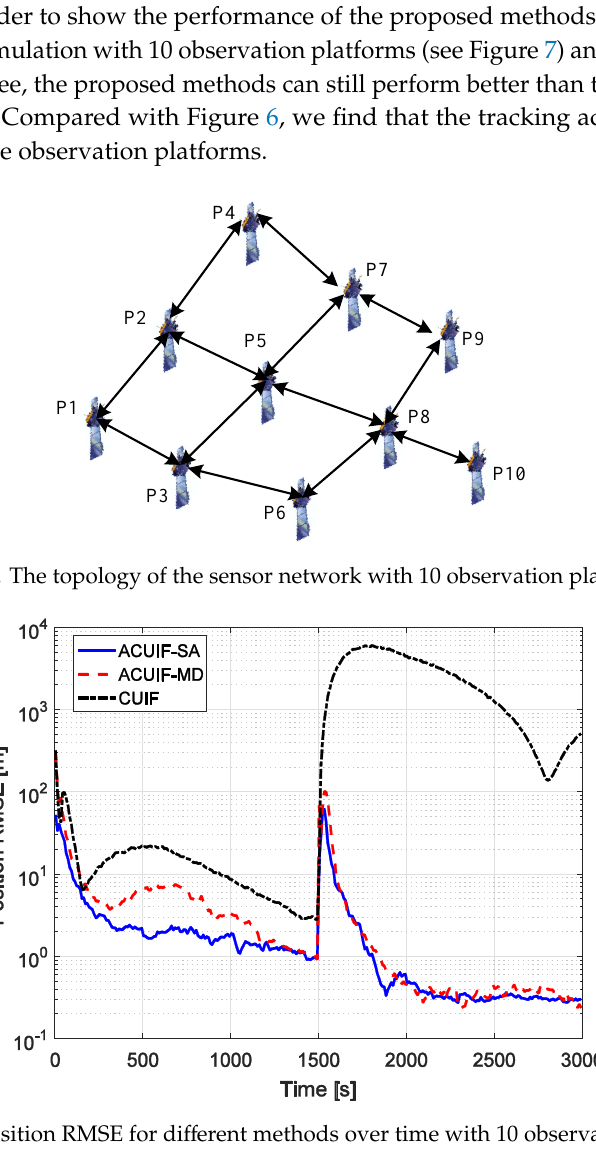
Figure 7. The position RMSE for different methods over time with 10 observation platforms. Figure 8. The position RMSE for di ff erent methods over time with 10 observation